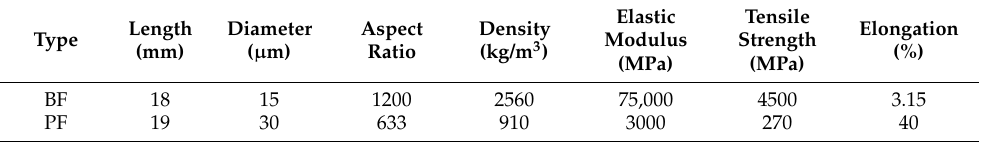
Table 2. Physical and mechanical properties of BF and PF.